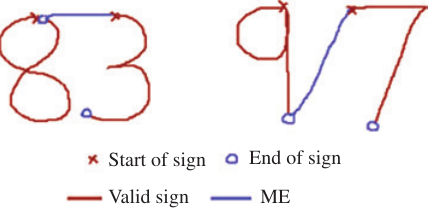
Figure 8: Examples of Continuous Sign Sequences “8–3” and “9–7.”